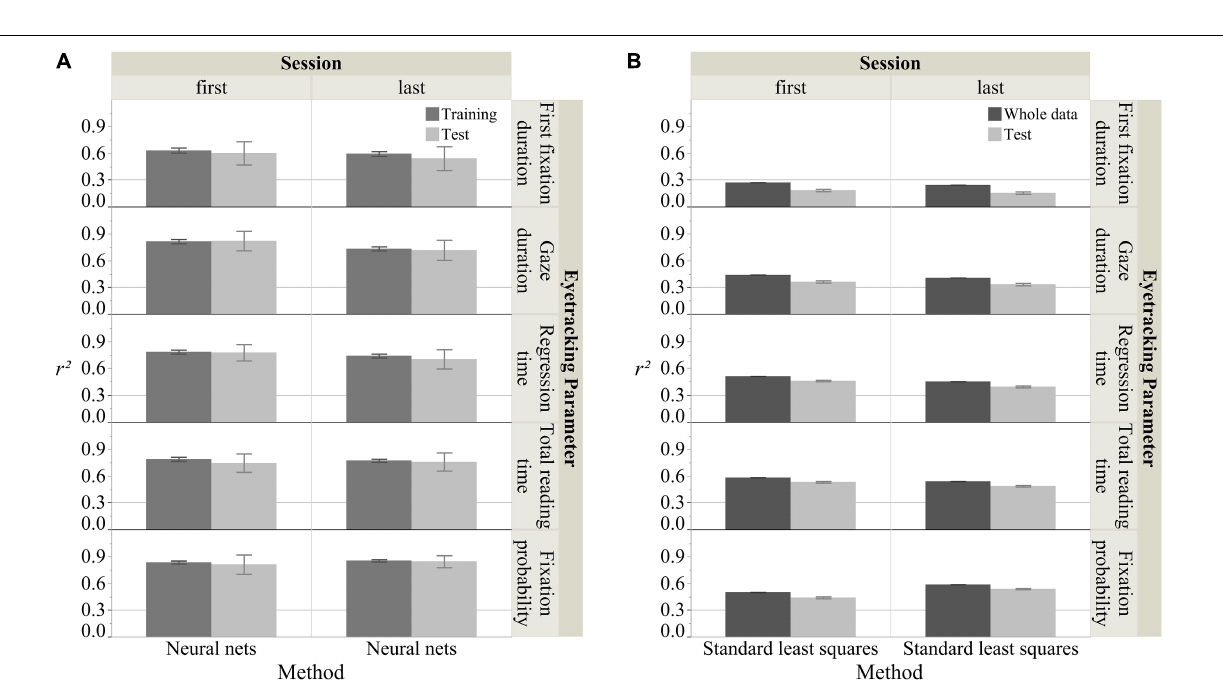
Frontiers in Psychology |